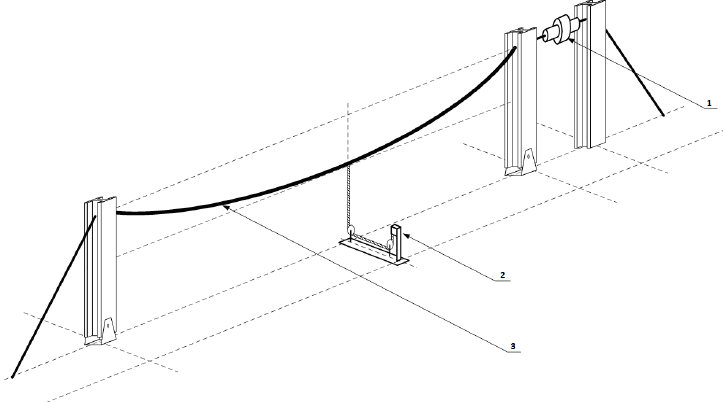
Figure 17. Measurement results using the interrogator presented in Figure 9 for the FBG + FBGF3 matched gratings pair: ( a ) change in the shape of the system output signal; ( b ) wavelength shift processing characteristics; ( c ) the characteristics of the power line conductor stress conversion to changes in the voltage on the photodetector.